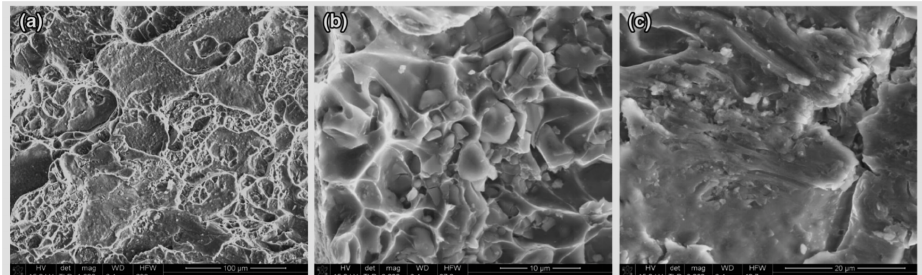
Figure 13. SEM micrographs of the fracture surface of 5083-H321 aluminum sample shock compressed to approximately 2.96 GPa. ( a ) Areas consisting of dimples resulting from void nucleation, growth, and coalescence with isolated areas of brittle fracture, ( b ) second phase Mn-Fe rich particles within the void dimples, and ( c ) smooth brittle-like surface